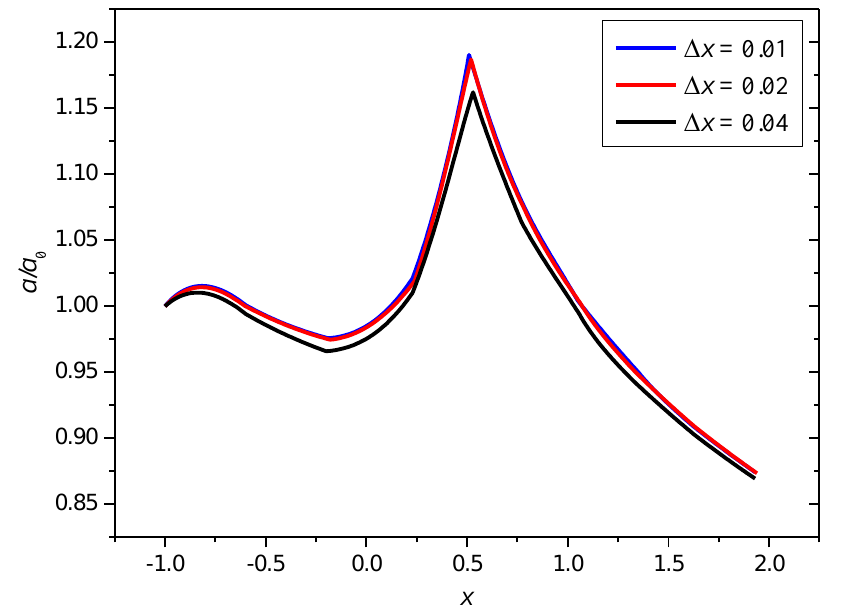
Figure 7. Validation of amplitude variation while ISWs propagating over slope bottom in regard to mesh sizes for the case a 0 /h 1 = 0.4 and h s = 0.18.